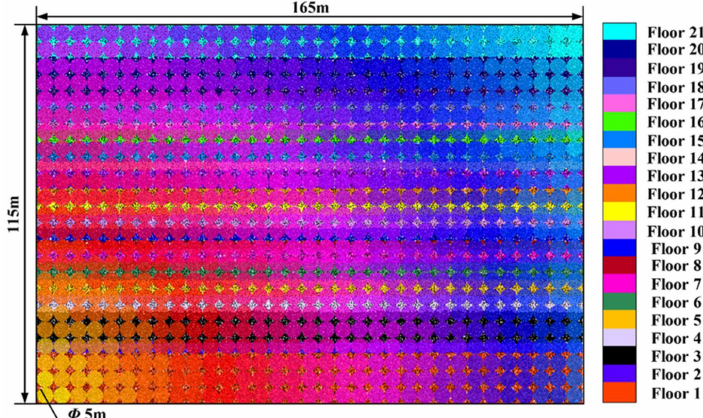
Figure 7. Schematic of the numerical simulation model for No.6303 face. The circle is used to monitor the dynamic change of porosity